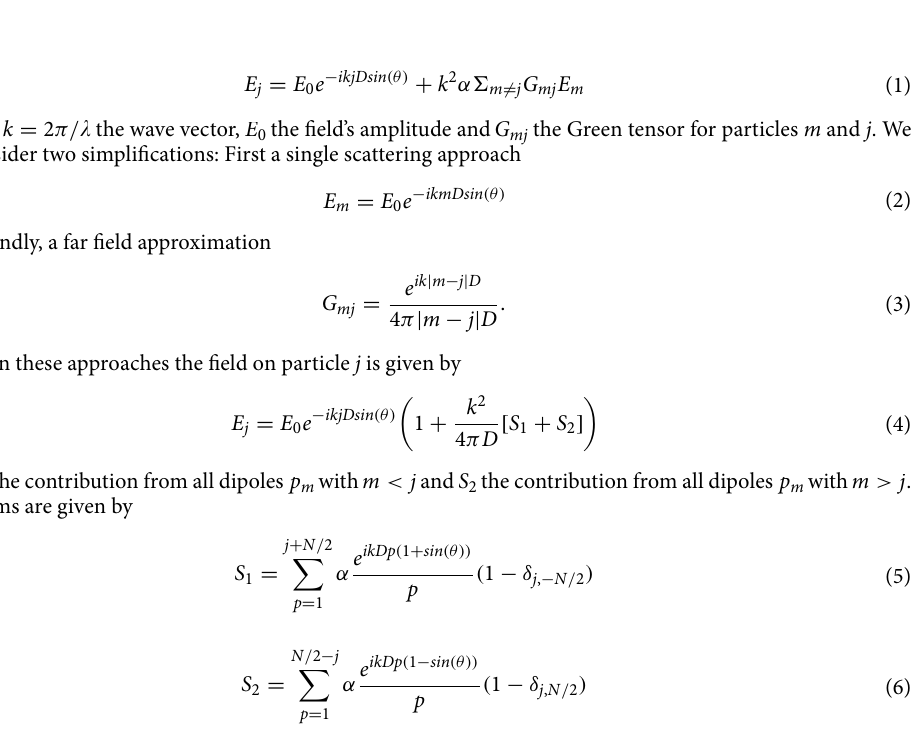
Figure 1. The system analyzed consists on a chain of N + 1 nanoparticles free to rotate an angle θ around the Z axis. The array is illuminated with a plane wave, Z-polarized, and propagating in the X direction. By considering each nanoparticle as a single electric dipole, the torque on the system and the equilibrium configurations are calculated using multiple scattering